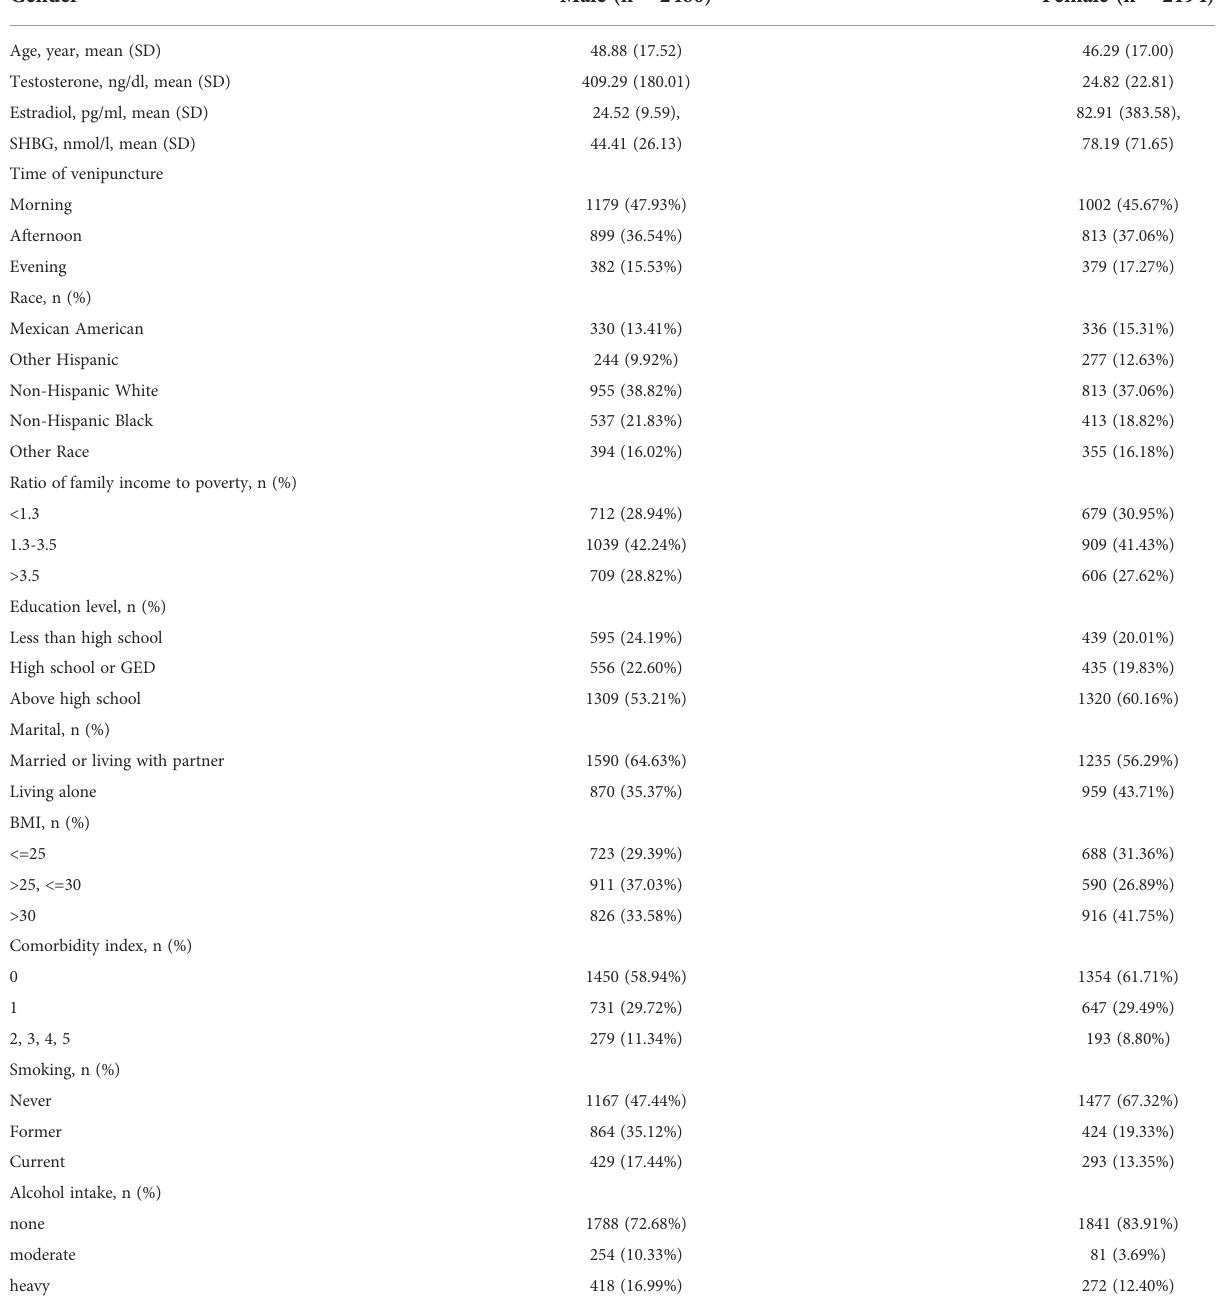
TABLE 1 Demographic and laboratory characteristics of 4,654